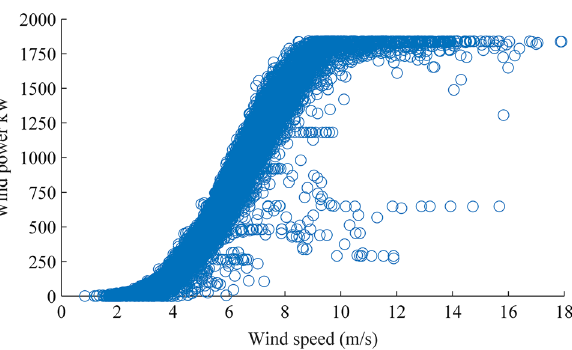
Figure 7. Scatter plot of wind power. There are a large number of outlier data points located far from the normal power bands. These abnormal and unreasonable data include the missing data by sensor fault, measurement error data and low temporal resolution data. Figure created using Matlab R2014a (https:// www. mathw orks. com).